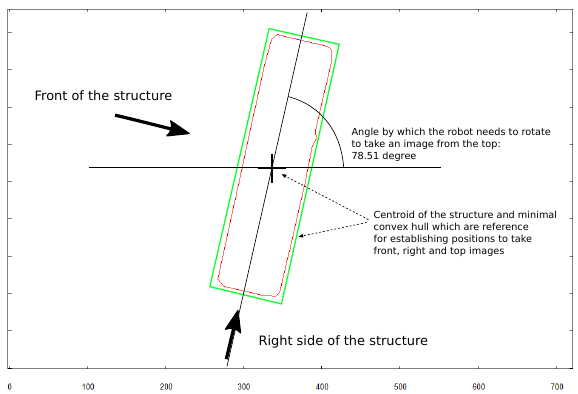
Figure 26. Calculating positions where robot needs to be positioned to take images for 3D model building.